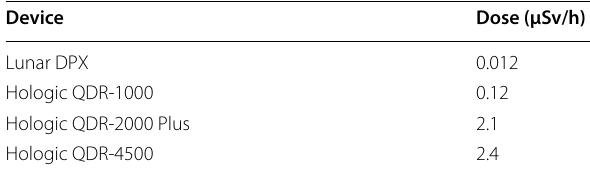
Table 6 Ambient dose equivalent averaged over 1 h at 1 m from the patient, using DXA systems at maximum patient throughput